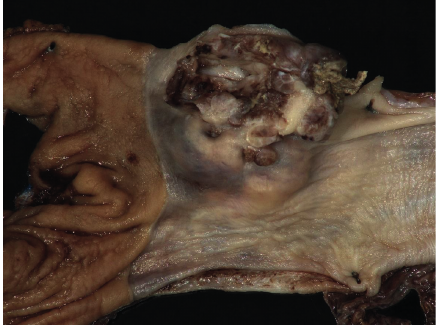
Figure 1: Gross image of the fixed esophagogastrectomy specimen.